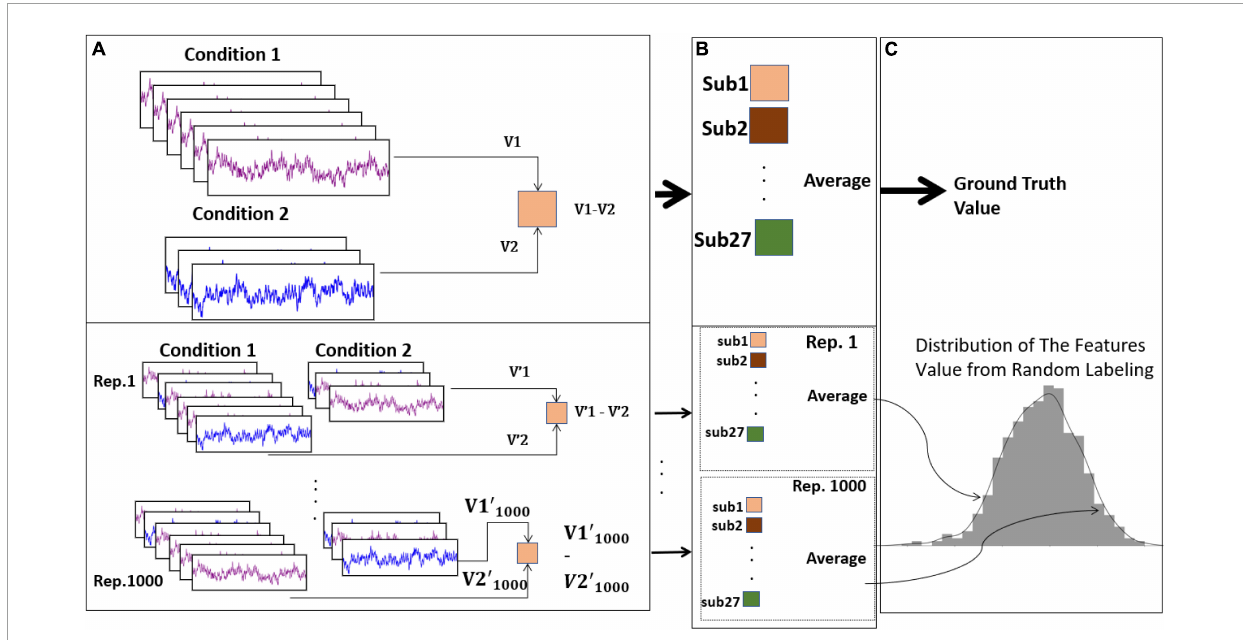
FIGURE2 The implemented statistical method for considering the imbalanced trials. In section (A) , the calculation of feature values has been shown. In the upper section, features from the actual conditions (V1, V2) have been calculated and then subtracted for each subject. In the lower section of (A) the same procedure is happening but with random shuffling of the labels across trials for 1,000 iterations. In section (B) we averaged the outcome of section (A) over subjects which the upper section shows for the actual condition and the lower section is for each iteration. In section (C) the ground truth value from the actual conditions and null distribution from the random shuffling is illustrated in the upper and lower side